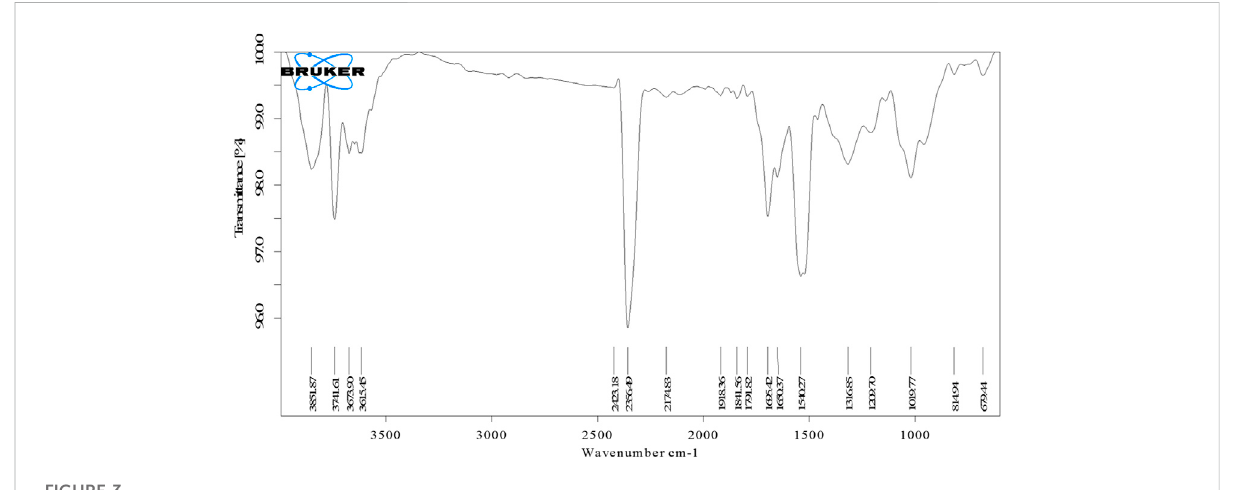
FIGURE 3 FTIR spectra of synthesized AgNPs.